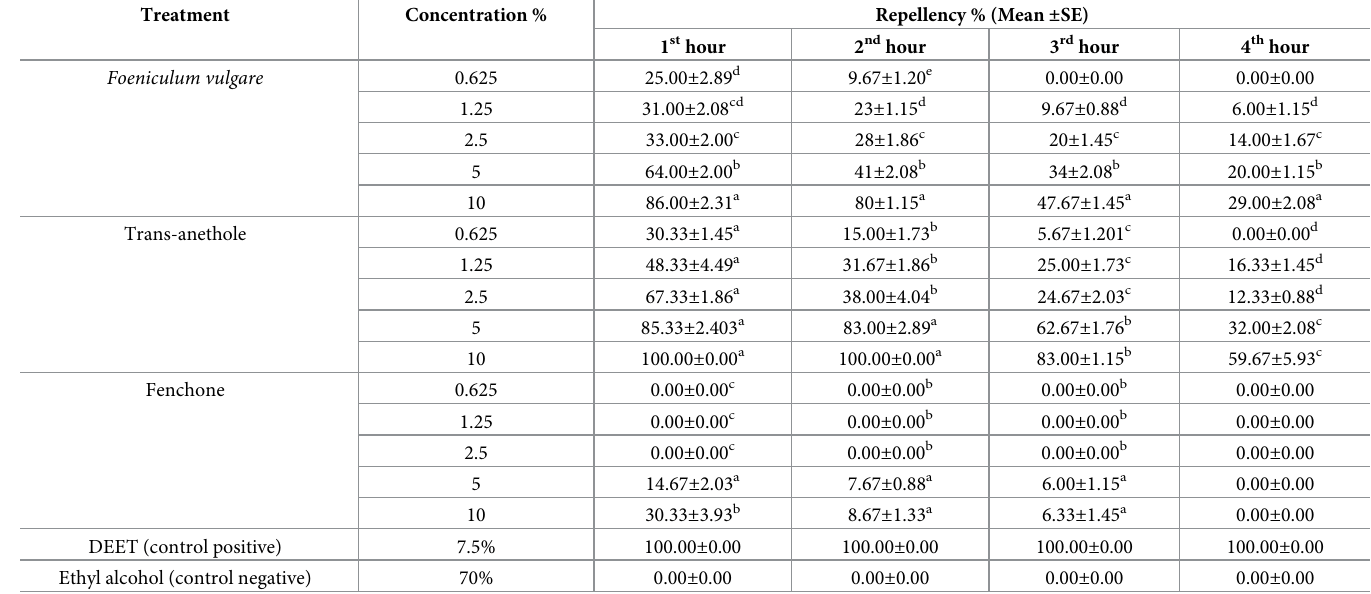
Table 4. Repellency percentages of Fennel oil, trans-anethole and fenchone against R . annulatus larvae.